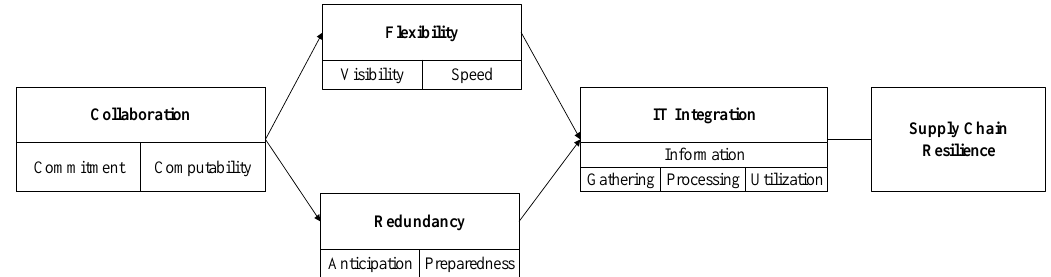
Fig. 2. Capabilities integration with industry 4.0 concept for supply chain resilience. Figure 2 indicates the approach of these capabilities to supply chain